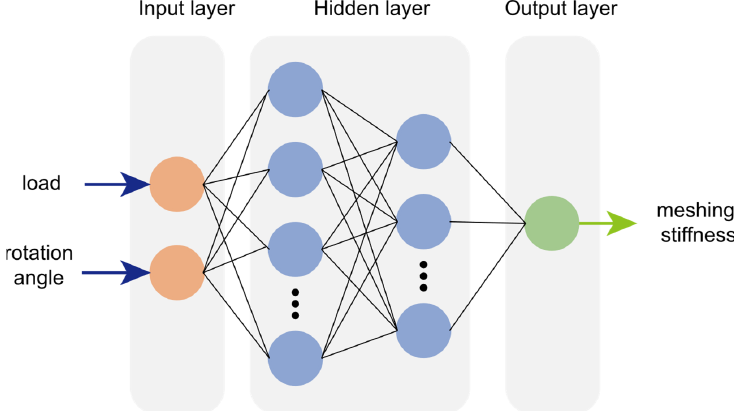
Figure 3. Multilayer feedforward neural network topology.